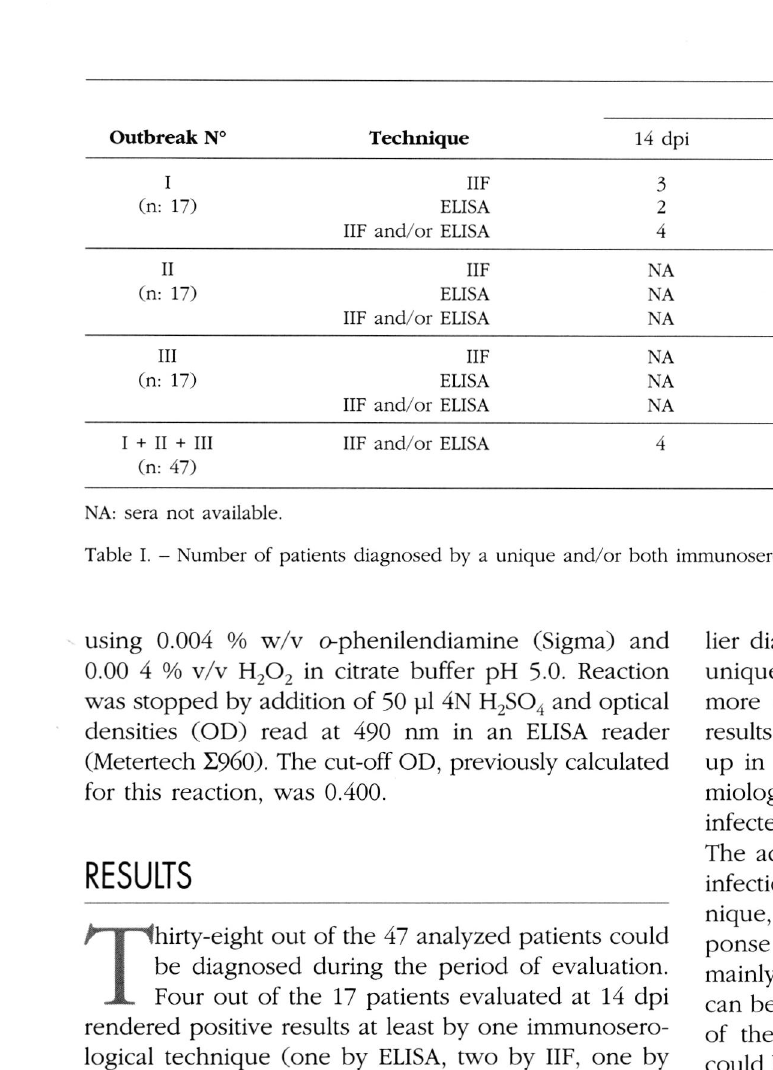
T hirty-eight out of the 47 analyzed patients